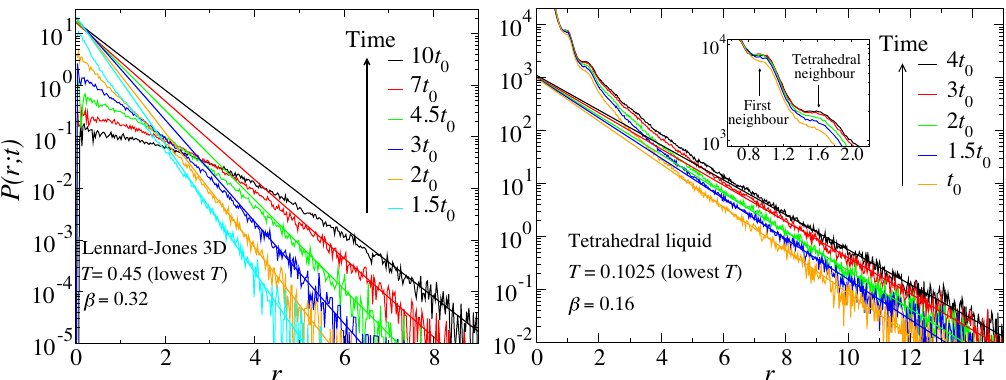
FIG. 9. Left: P ð r ; t Þ at different times t ( > t 0 ) for the 3D Kob-Andersen binary mixture at the lowest temperature investigated ( T ¼ 0 . 45 ). Right: P ð r ; t Þ at different times t ( ≥ t 0 ) for the tetrahedral gelling system at the lowest temperature investigated ( T ¼ 0 . 1025 ). The inset in the right figure shows a detail of P ð r ; t Þ at distances corresponding to the first and tetrahedral neighbors. Straight lines for both systems correspond to the exponential tails of the different P ð r ; t Þ , extended to r ¼ 0